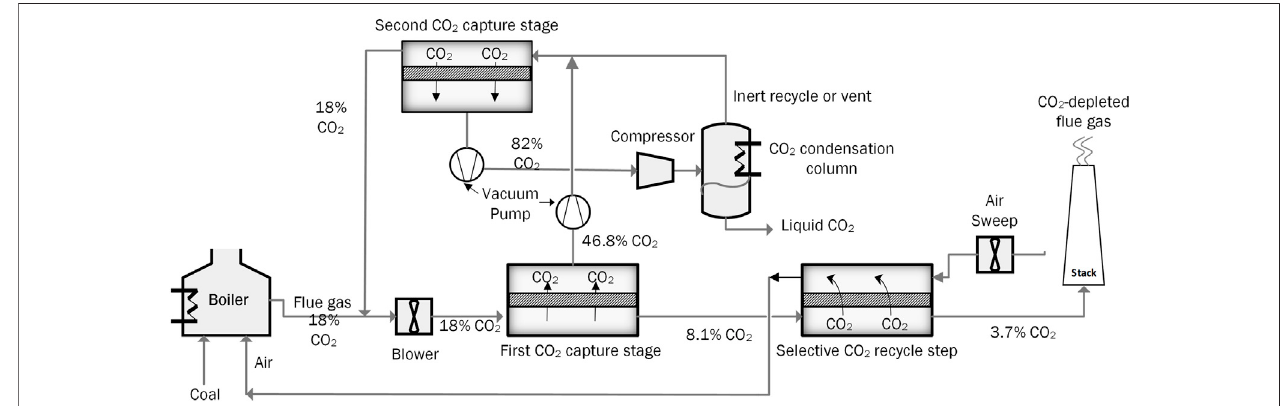
FIGURE6| Asimpli fi edprocess fl owdiagramillustratingtheimpactofaselectiverecyclemembraneonatwo-stagemembranesystem.Therecyclestepraisesthe